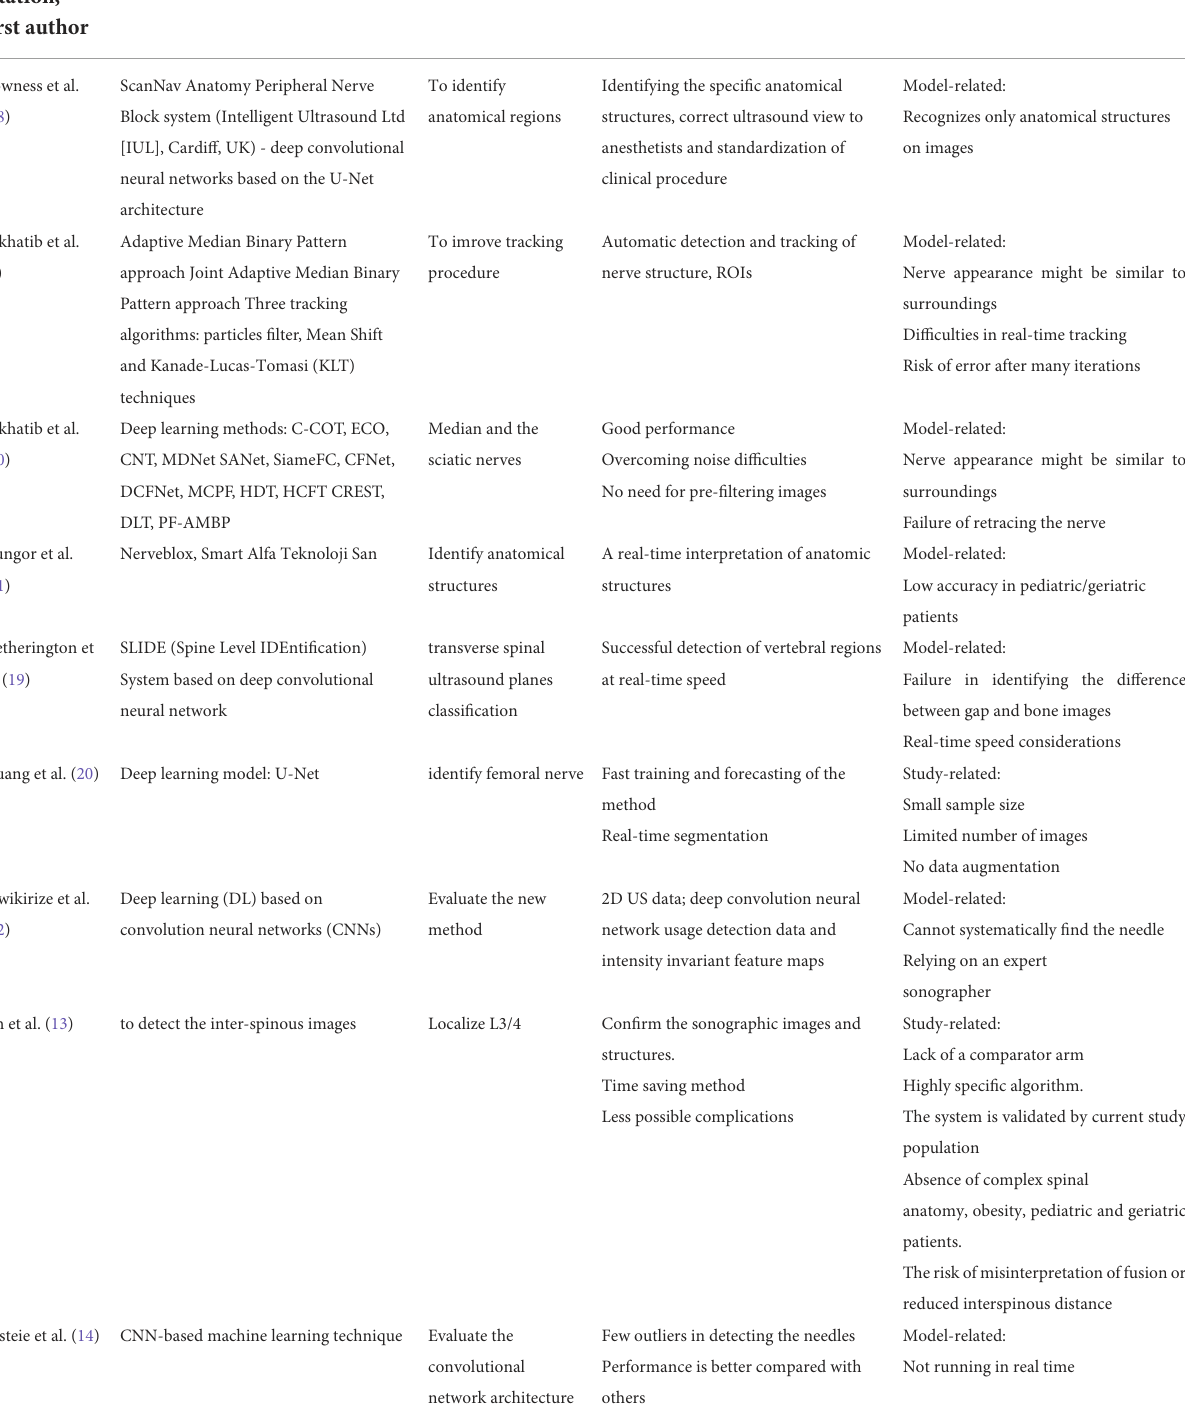
TABLE 2 Artificial intelligence method and its